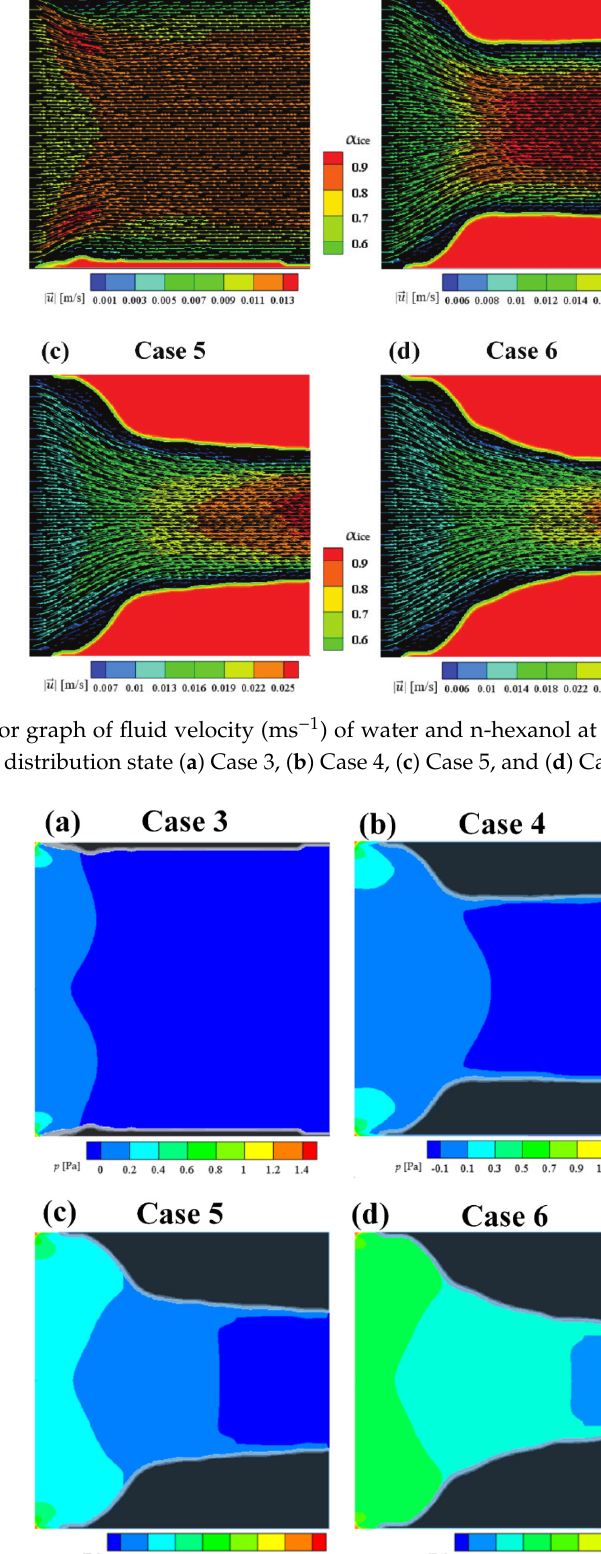
Figure 13. Distributions of cryogenic fluid, water and ice (phase fraction) at t = 0.5 s under different